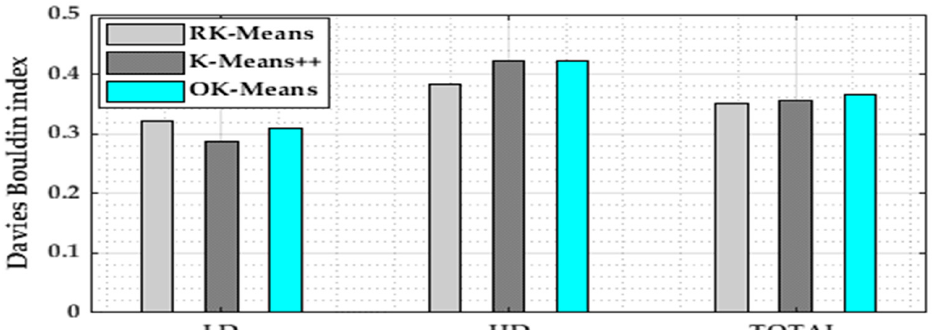
Figure 13. SC comparison results.